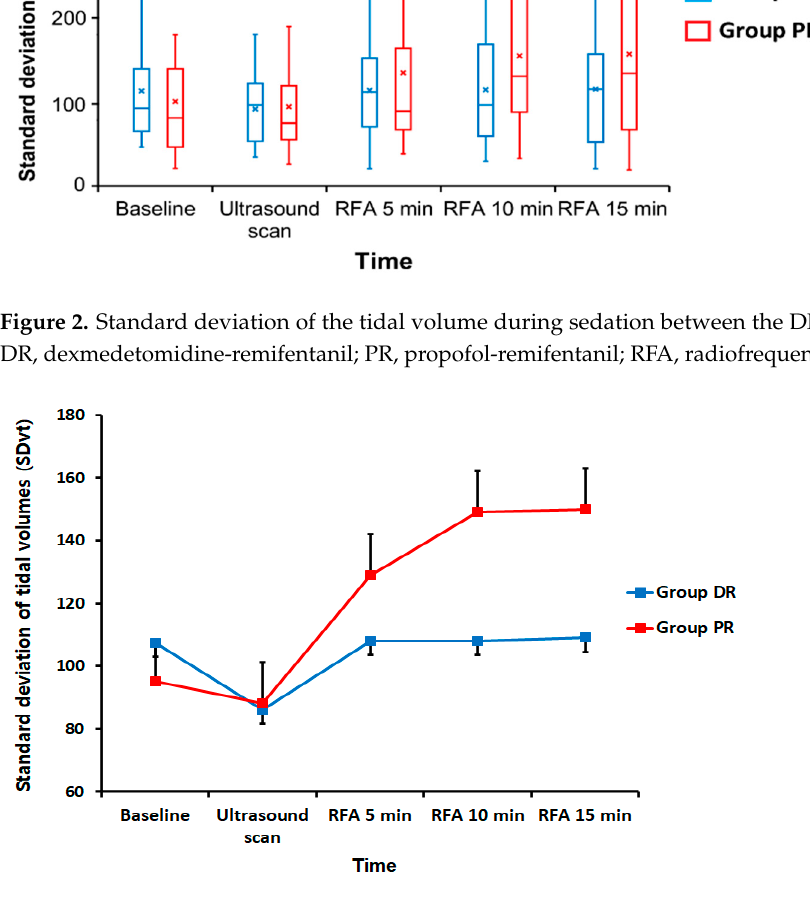
Figure 3. Standard deviation of the tidal volume (SDvt) over time during sedation between the DR and PR groups. The SDvt of PR group was increased over time ( p = 0.004, ß = 0.142). DR, dexmedetomidine-remifentanil; PR, propofol-remifentanil; RFA, radiofrequency ablation. Additionally, the trend for the EtCO 2 level over time was significantly different between the two groups ( p = 0.021, ß = − 0.910). The extent in increase of the EtCO 2 level in the PR group was larger than that in the DR group over time (DR group, p < 0.001 and ß = 2.860 vs. PR group, p < 0.001 and ß = 3.780; Figure 5a). The HR decreased over time in the DR group ( p = 0.002, ß = − 1.650; Figure 5b), and showed no significant changes